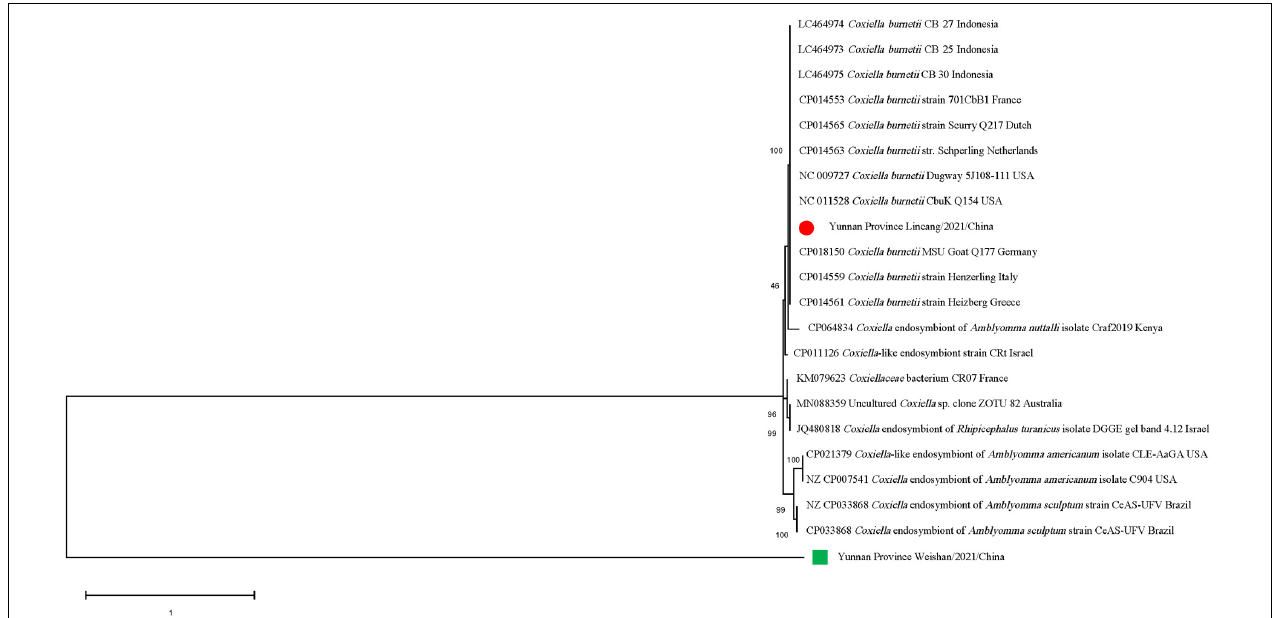
FIGURE 5 | Phylogenetic tree of Coxiella spp. in ticks based on partial 16S rRNA gene sequence similarity. The sequences obtained in this study are indicated with a colored dot. Sequences were aligned using the MEGA X (Version 10.2.5) software package. Phylogenetic analysis was performed by the maximum likelihood method and bootstrap values were estimated for 1,000